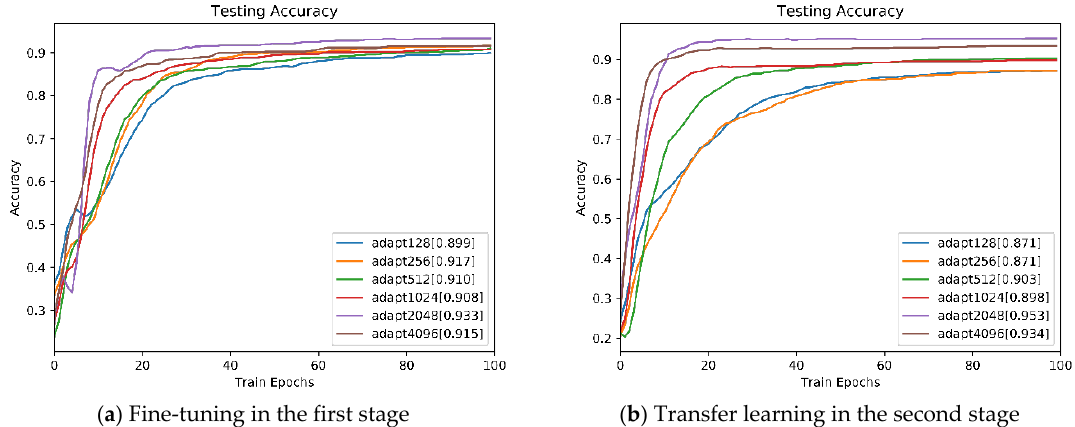
Figure 8. Transfer learning with different adaptive layers: ( a ) Fine-tuning with different adaptive layers in the first stage; ( b ) Transfer learning with different adaptive layers in the second stage; Different lengths of adaptive fully connected layers were tested in both stages. Transfer learning with adaptive layers 2048 achieves best results.